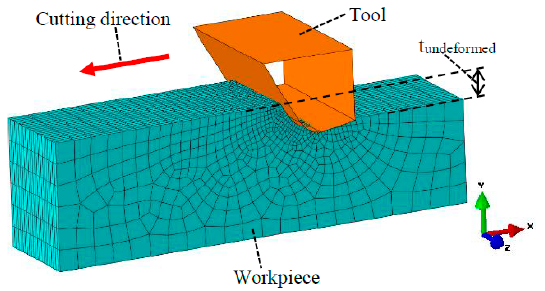
Figure 6. Elastic deformation finite element method (FEM) model of orthogonal cutting.